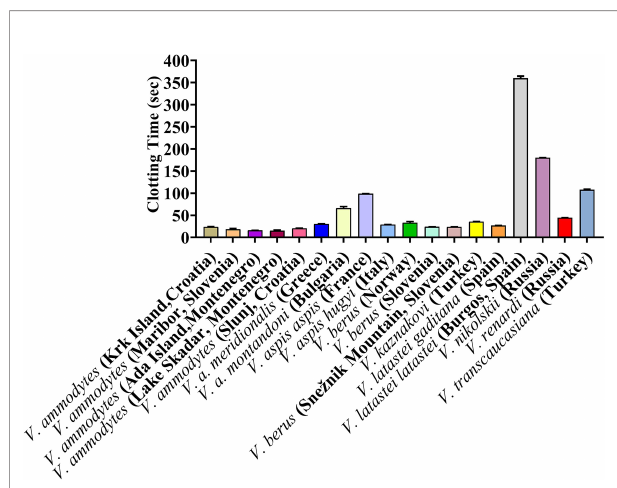
FIGURE 3 | Clotting times on human plasma produced by Vipera venoms (20